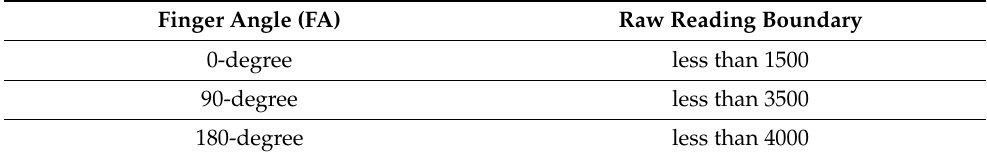
Table 10. Finger angle and raw reading boundary.